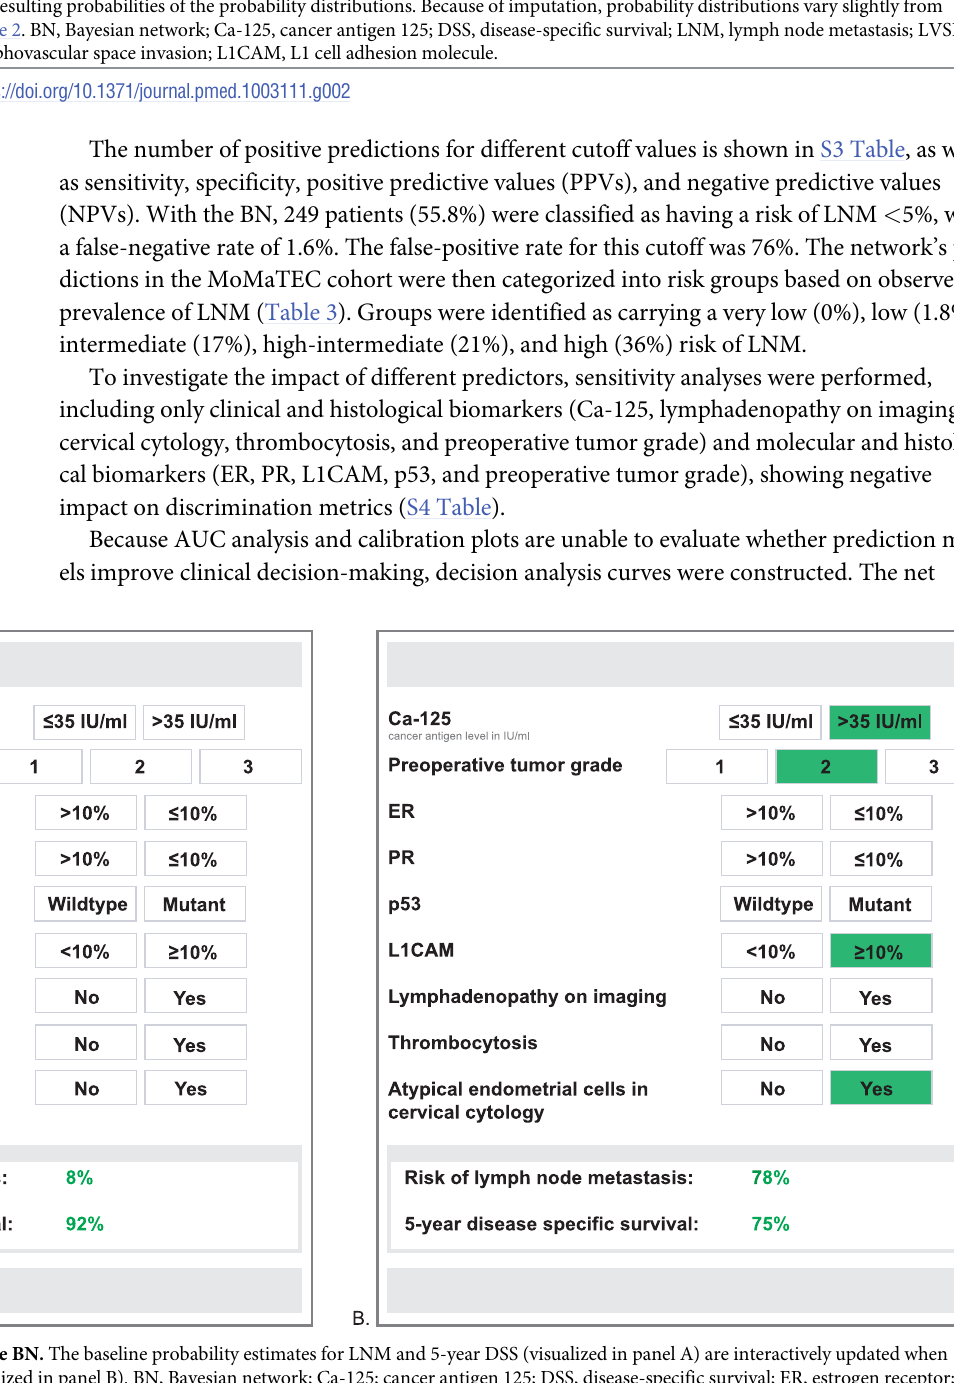
Fig 2. Final BN for the prediction of LNM and 5-year DSS. (A.) Probability estimates are shown when no markers were recorded. (B.) Example of probability estimates in a case with preoperative tumor grade (grade 2), cervical cytology (atypical endometrial cells present), L1CAM expression (positive), and Ca-125 serum levels ( > 35 IU/ml). Probability distributions are shown in the nodes, and dependencies are indicated by the arrows connecting the nodes. If variables are not connected directly or indirectly, they are assumed to be (conditionally) independent. Often, the direction of the arrows can be given causal meaning. Red bars indicate that the specific variable is instantiated, i.e., a specific value or evidence is provided. Blue bars in the bar plots indicate the resulting probabilities of the probability distributions. Because of imputation, probability distributions vary slightly from Table 2. BN, Bayesian network; Ca-125, cancer antigen 125; DSS, disease-specific survival; LNM, lymph node metastasis; LVSI, lymphovascular space invasion; L1CAM, L1 cell adhesion molecule.